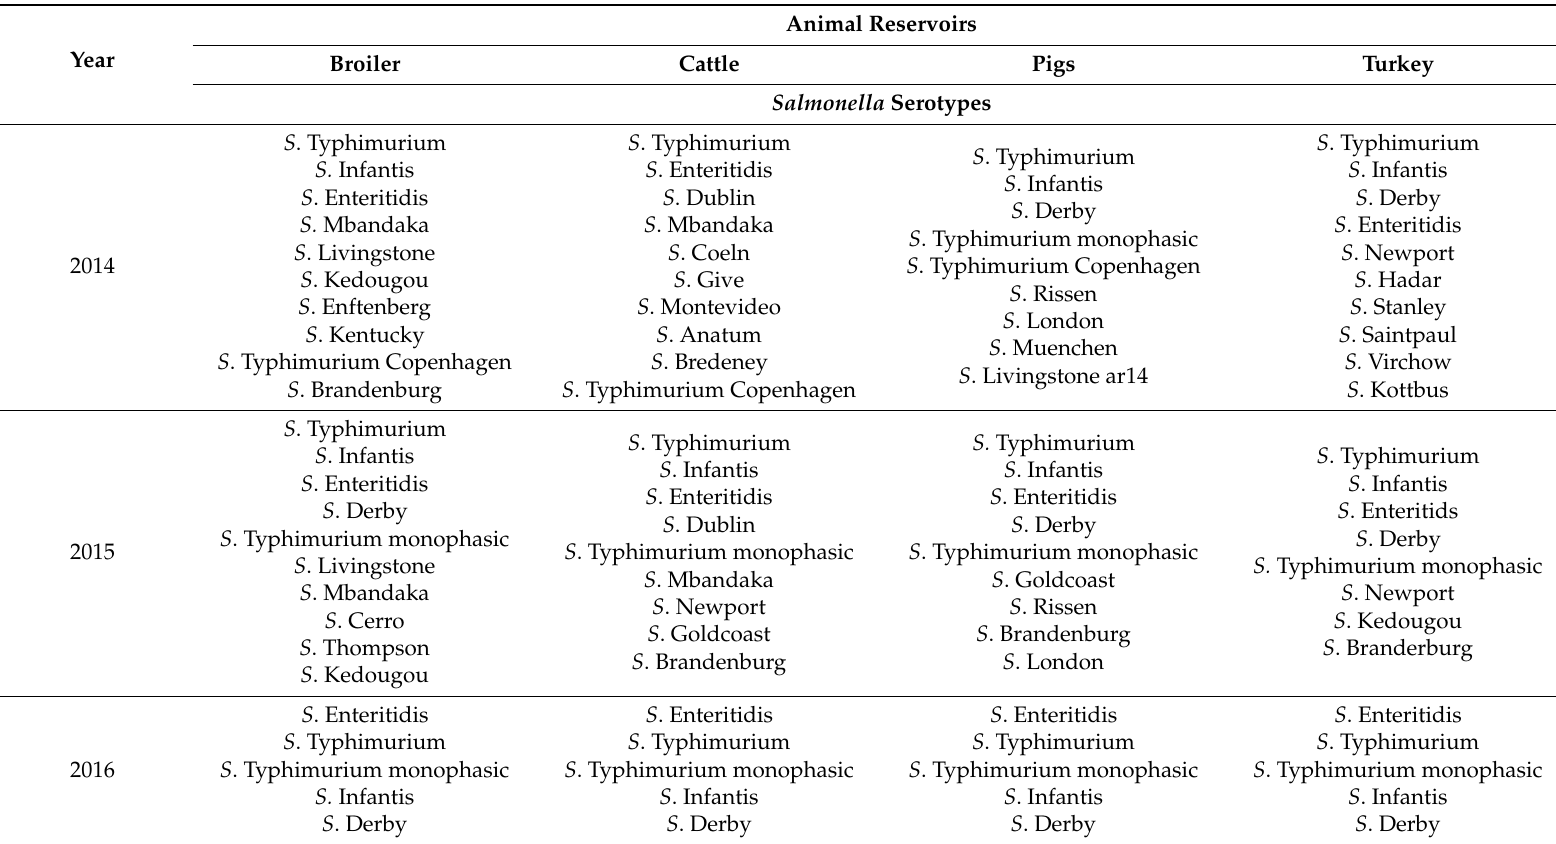
Table 3. Salmonella spp. serotypes most often isolated from animal reservoirs in European Union countries. Underlined serovar was the one isolated most frequently